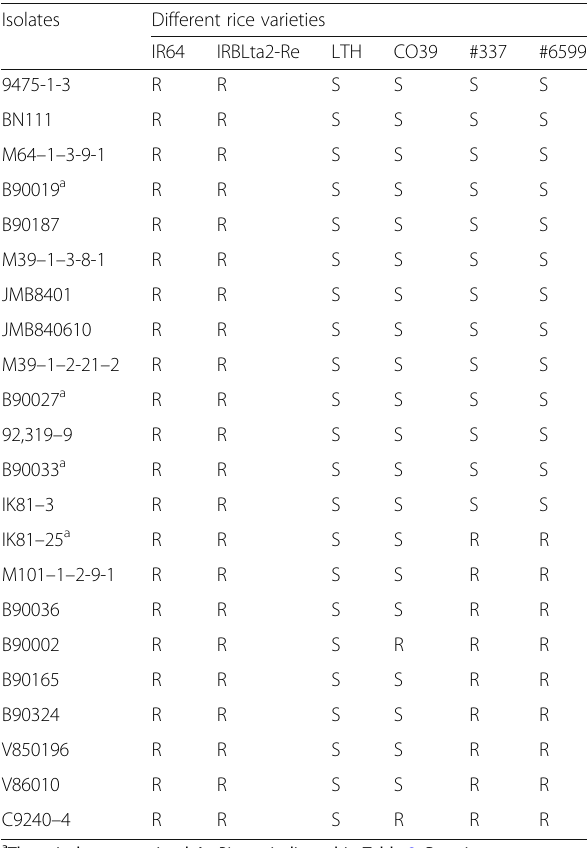
Table 3 Pathogenicity test of differential isolates to different Pita2 lines